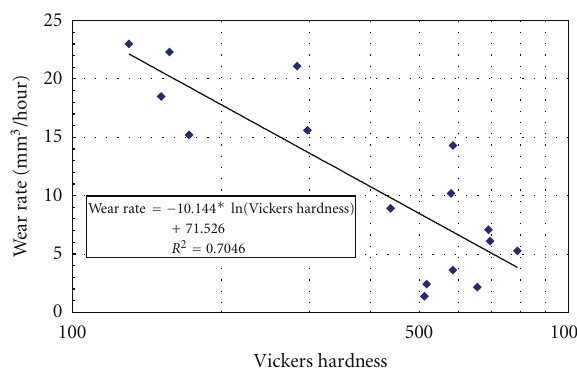
Figure 3: Wear rate data of Miller and